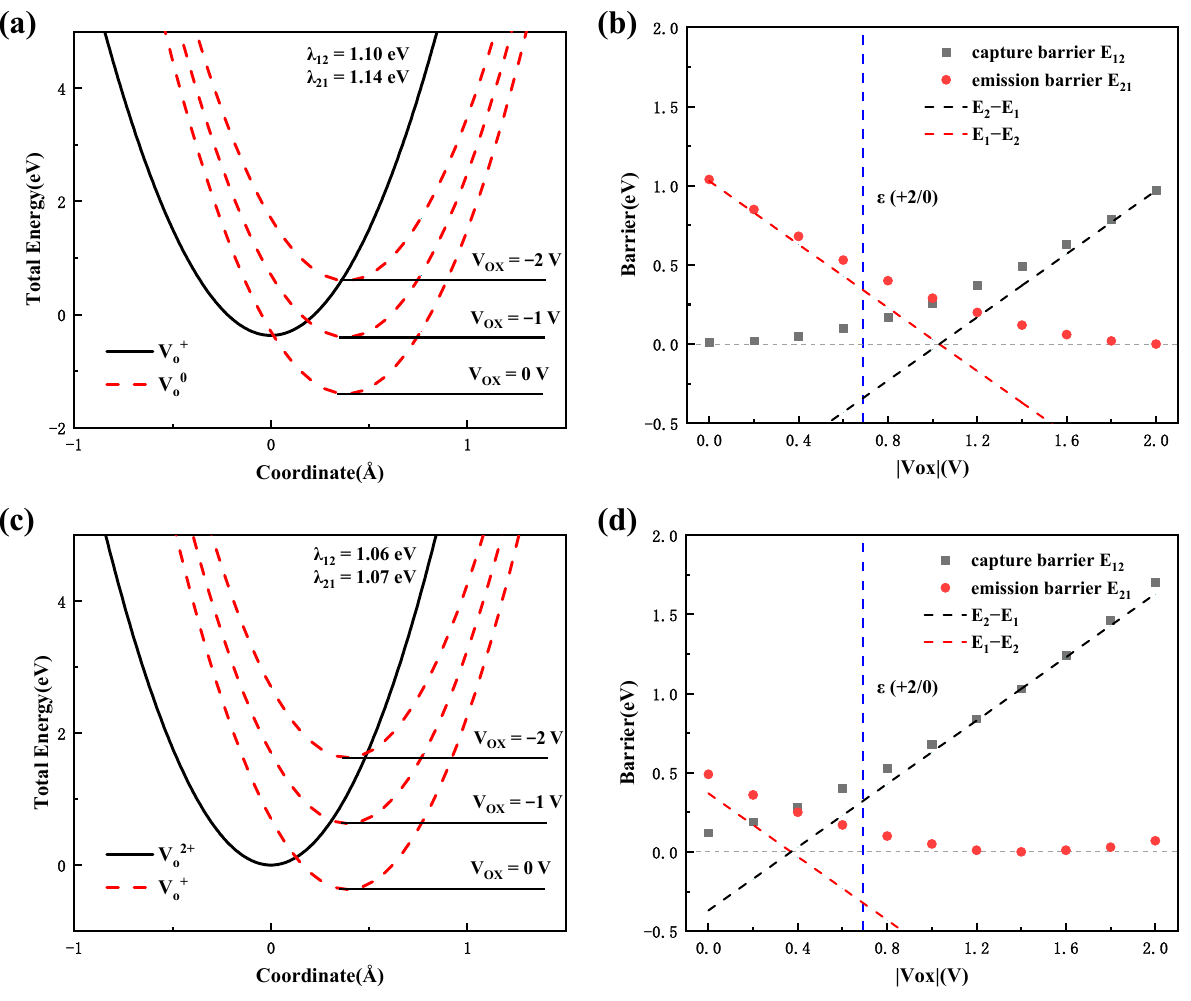
Figure 11. The total energy as a function of reaction coordinates for the oxygen vacancies in Al 2 O 3 dielectric layer, ( a ) from V 0 to V + and ( c ) from V + to V 2 + . The red dashed line is the total energy curve for the charge state at different V ox . The energy barrier as a function of V ox , ( b ) from V 0 to V + and ( d ) from V + to V 2 + . The blue dash line represent the transition level ε (+2/0).